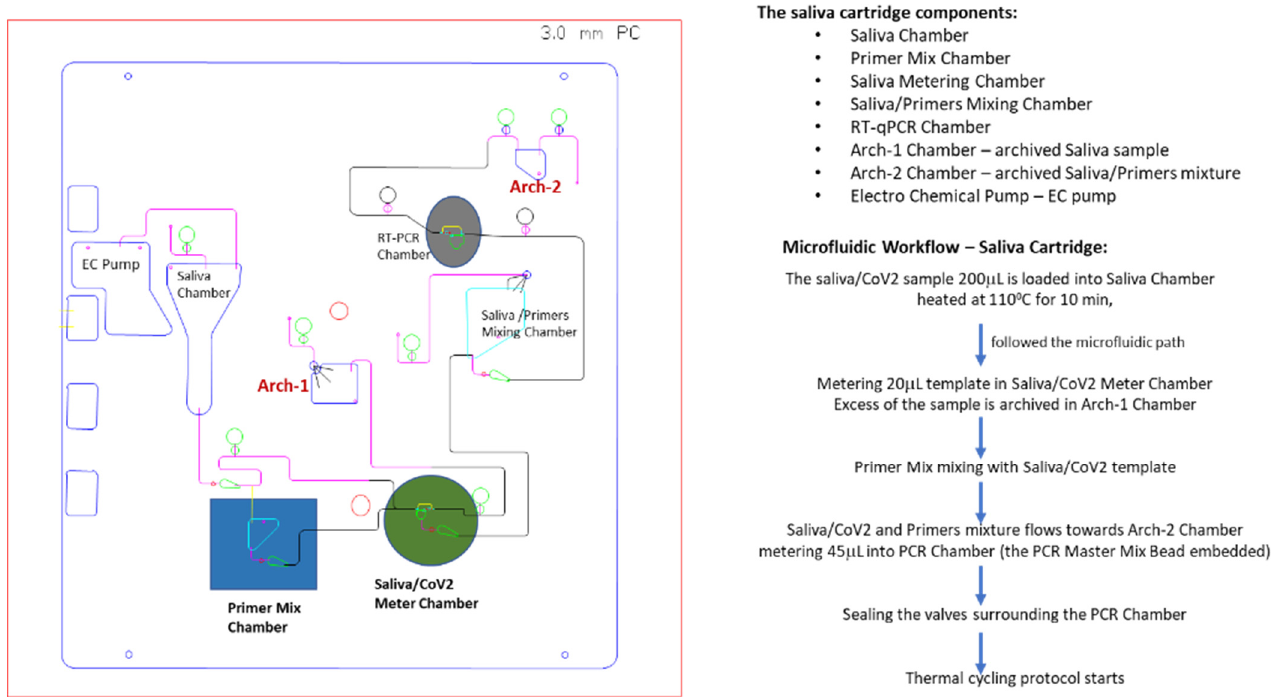
Figure 1. Schematic illustration of SARS-CoV-2 RT-qPCR cartridge layout. A saliva cartridge is composed of several chambers (saliva chamber, primer mix chamber, saliva/SARS-CoV-2 meter chamber, saliva/primers mixing chamber, RT-PCR chamber, and archive chambers), connecting channels, valves, and pumps. Each functional chamber is labeled corresponding to its content. The saliva cartridge microfluidic workflow and volumes are outlined and indicated.